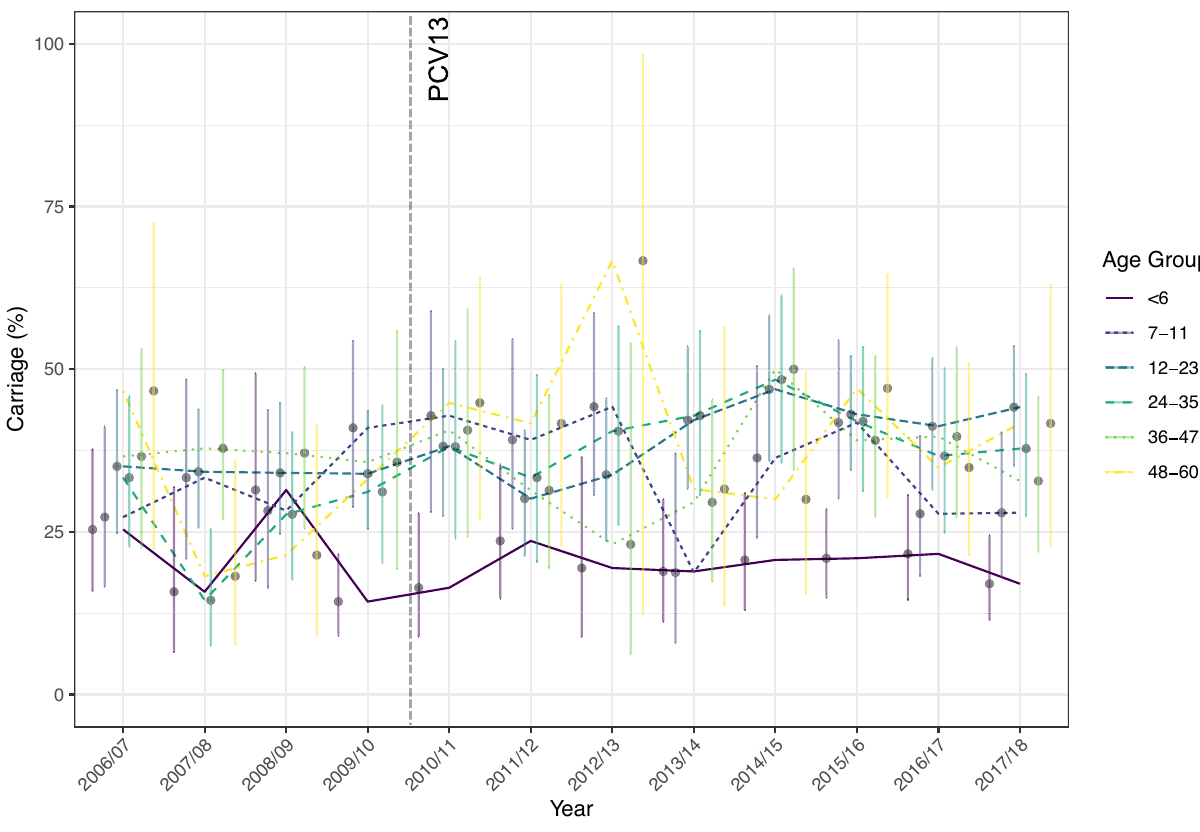
Figure 2. Carriage prevalence (%) of S. pneumoniae (all serotypes) by age group and year. Introduction of PCV13 is shown by the vertical line. Error bars represent 95% CI. Statistically significant increases in carriage in those aged 24–35 ( p < 0.001) and 48–60 ( p < 0.05) months old were shown by Chi-squared test for changes in trends of proportion.